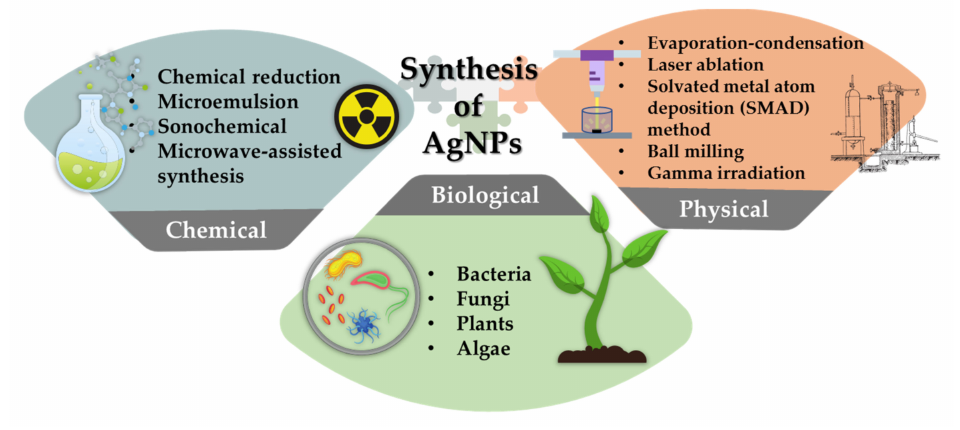
Figure 1. Synthesis of